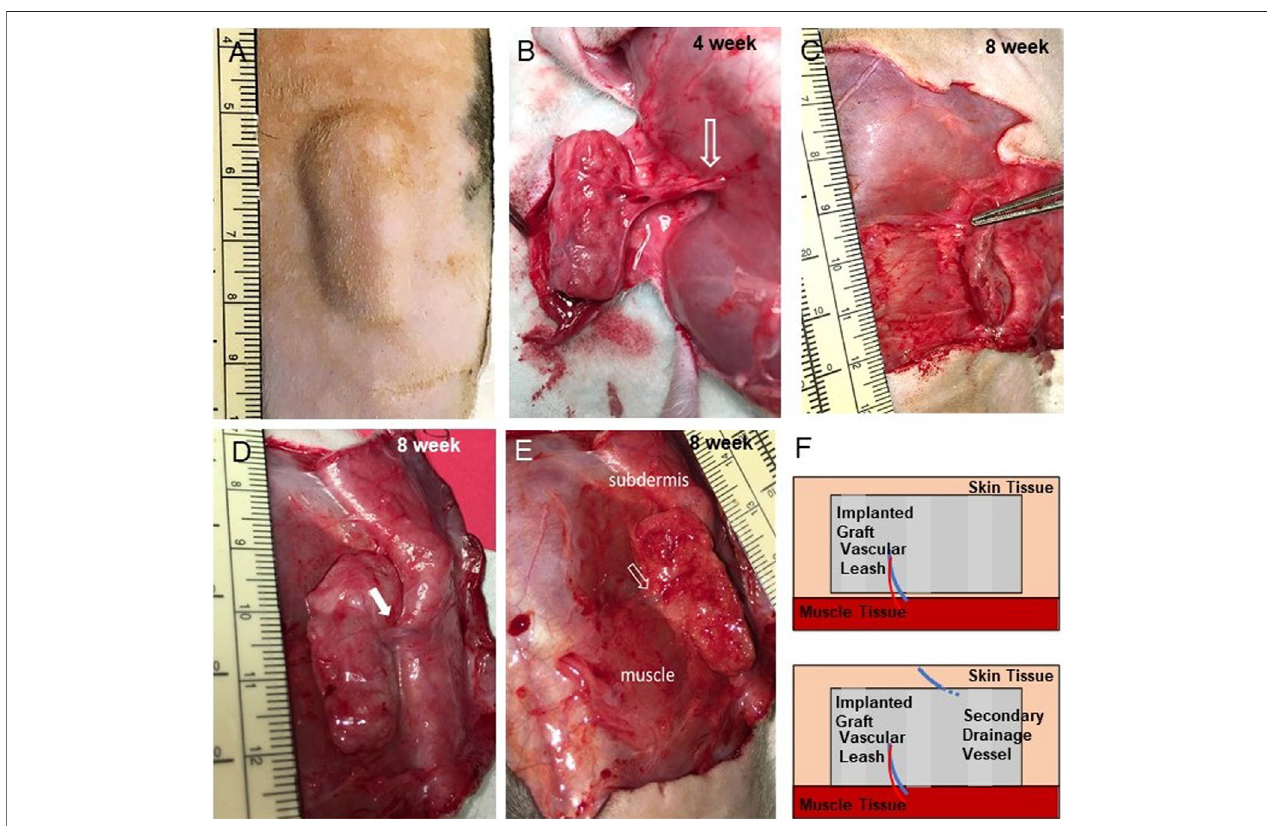
FIGURE 2 | Implants are well integrated and develop vascular leashes. (A) Exterior view of implanted graft at 4 weeks prior to explant (incision scar is located bottom right, graft 684). (B) An exposed implant at 4 weeks (graft 681) showing an intact artery/vein pair (open arrow) arising from the fl ank musculature that persisted from into week 8 (see panel E ). (C) Side view of 8 weeks graft following partial dissection showing thinning (compression) of the graft (graft 688). (D,E) Dermal-side and muscle-side views, respectively, of 8 weeks implants a secondary vein (closed arrow) that developed from the subdermal tissue and the fi rst vascular leash (open arrow, graft 677). (F) Schematic of the vascular leashes associated with the graft over time that arose from the muscle tissue (at week 4) and the subdermis (at week